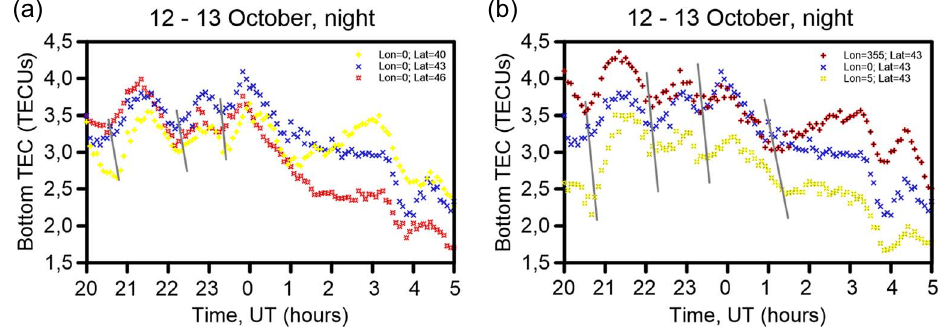
Fig. 4. (a) Time variation of the VTEC1 estimated for given latitudes but for fi xed longitude of 0 (cid:3) ; and (b) time variation of the VTEC1 estimated for given longitudes but for fi xed latitude of 43 (cid:3) .